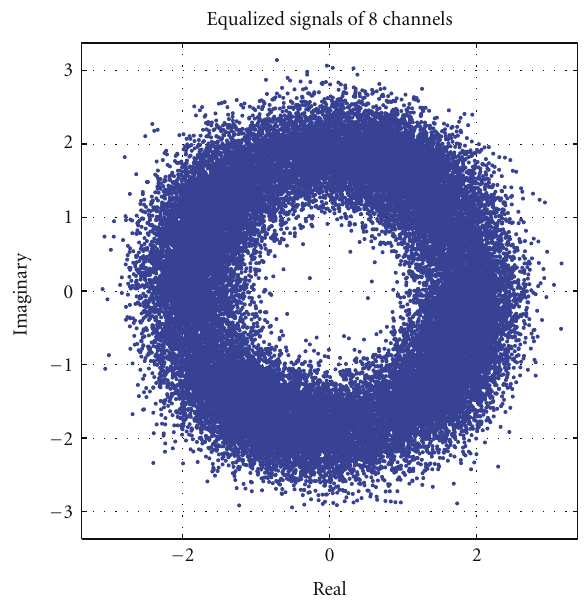
Figure 14: Scatter plot of equalized QPSK symbols using eight channels in Unet06 experiment.